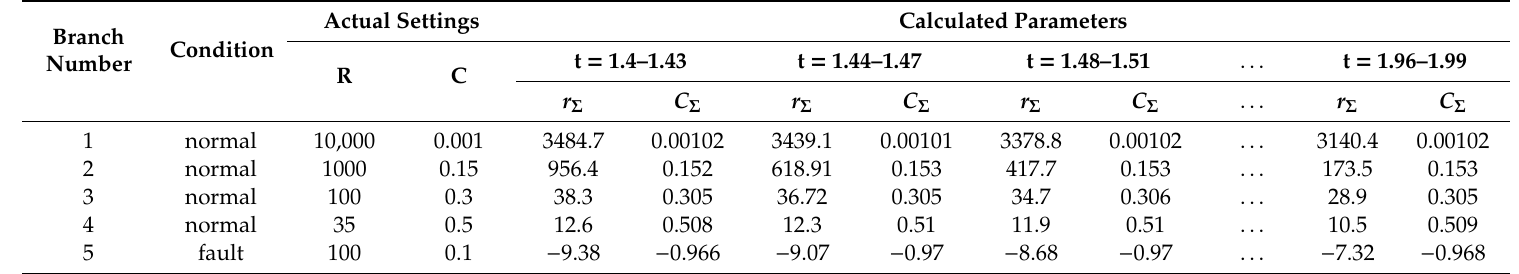
Table 3. The result of the emulate when the extreme circumstance of single-phase earth leakage fault occurred ( R g = 11000 Ω ). (resistance: k Ω ; capacitance: µ F; time: